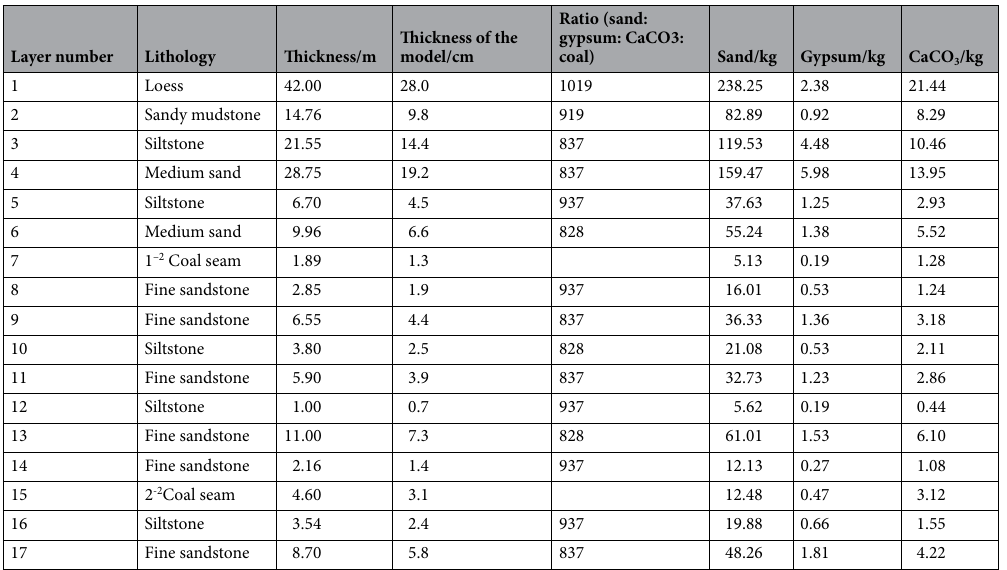
Table 1. Physical and mechanical properties of the strata.